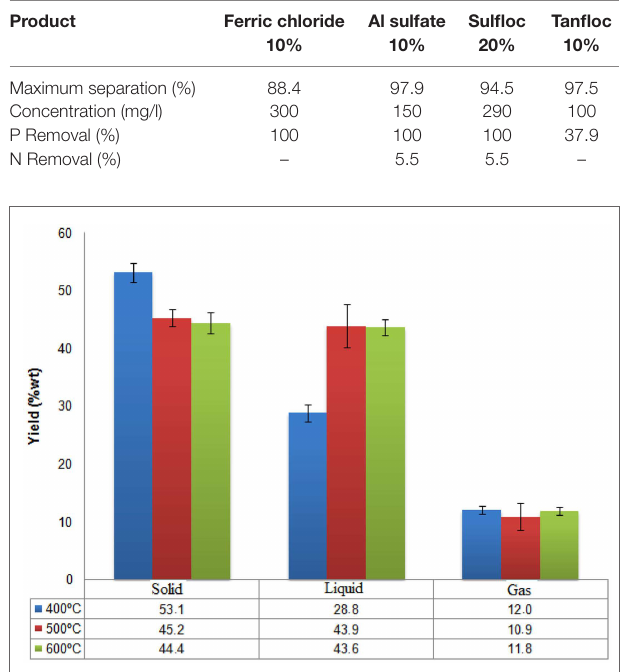
TaBle 5 | removal obtained and dosage